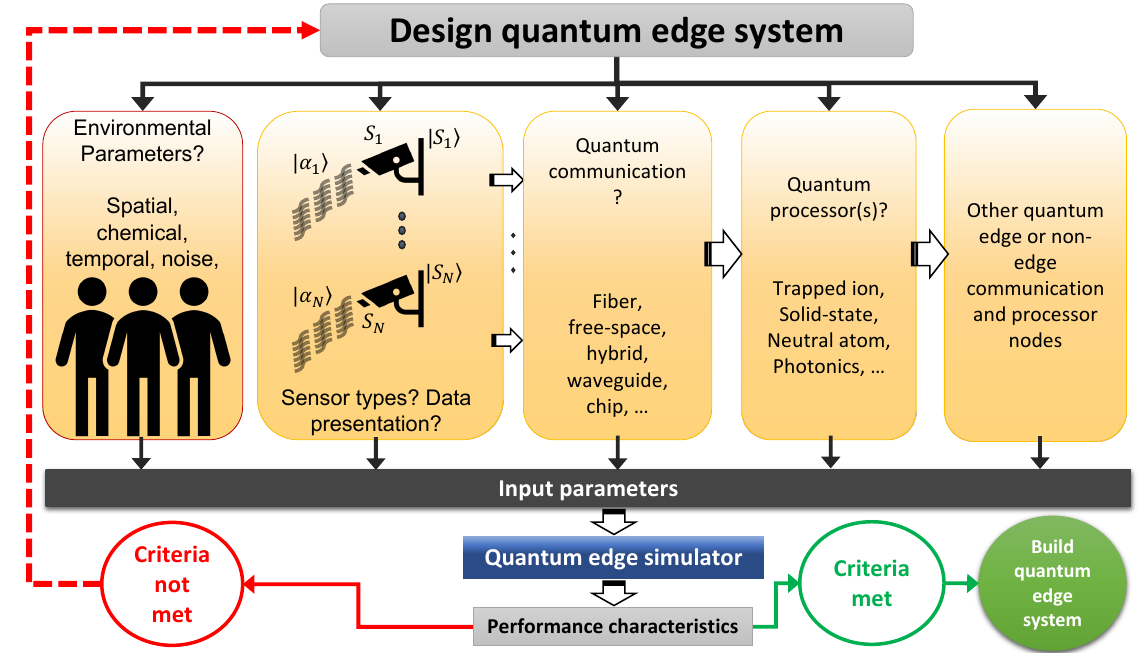
Figure 1. Depiction of a plausible standard framework for designing EQC systems and simulator requirements for effective design and evaluation. A well-established edge architecture requires many algorithms, models, parameter specifications, and optimizations for various types of processors, memory, network devices, noise, and other decoherence sources. Such a simulation would require a significant amount of processing power, processing speed, and the ability to co-process classical bits and qubits, a task that is likely outside the capabilities of a classical simulator.